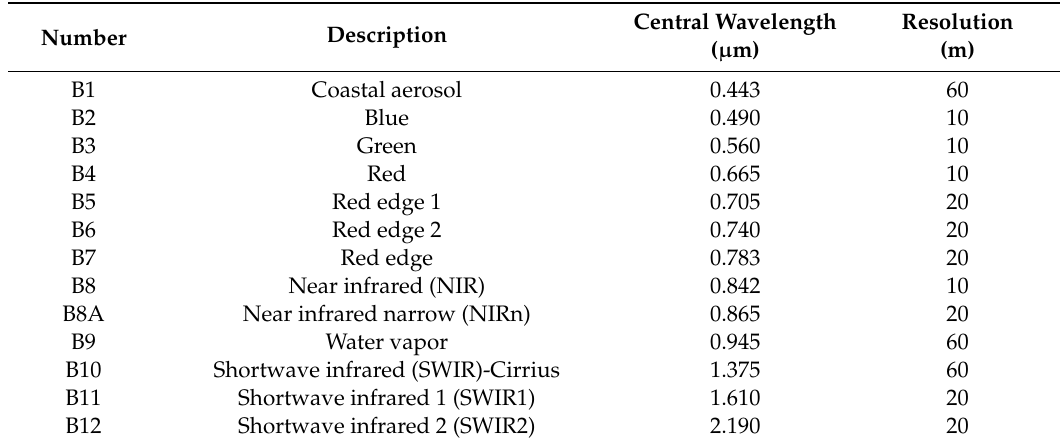
Table 1. Central wavelength and spatial resolution of Sentinel-2 imagery.